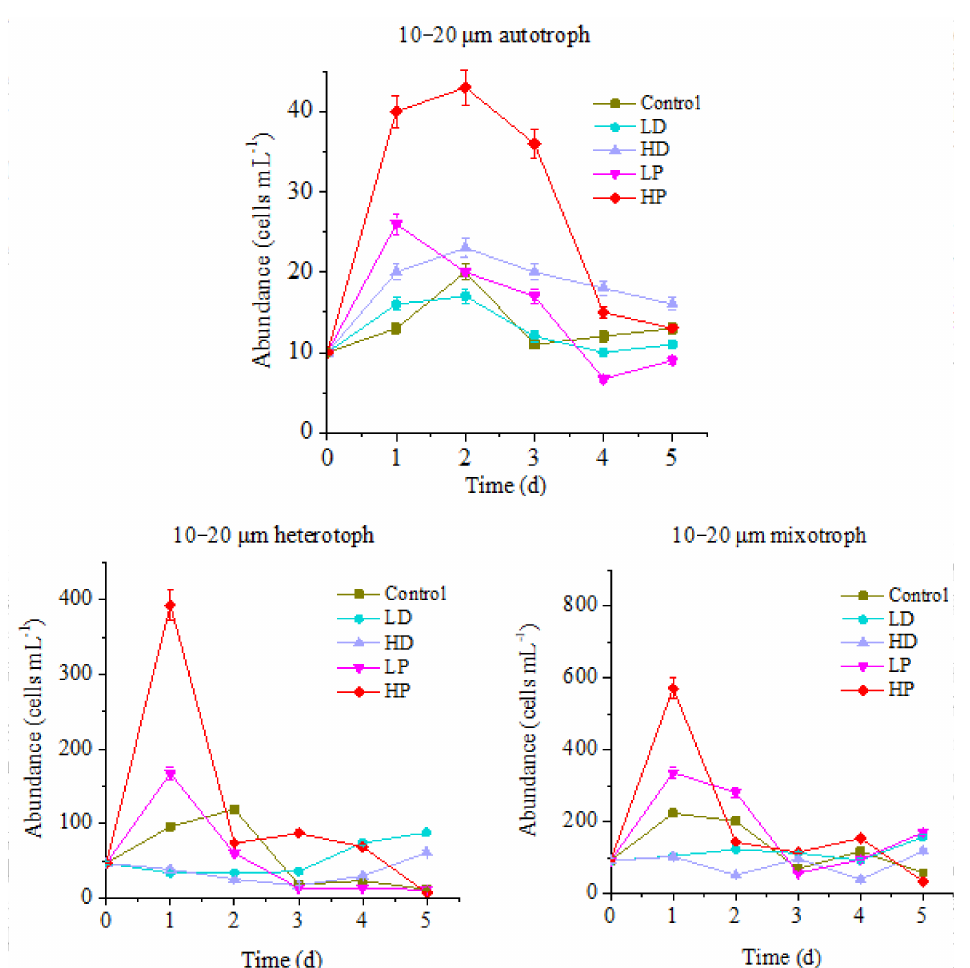
Figure 2. Variations in abundance of 10–20 µ m